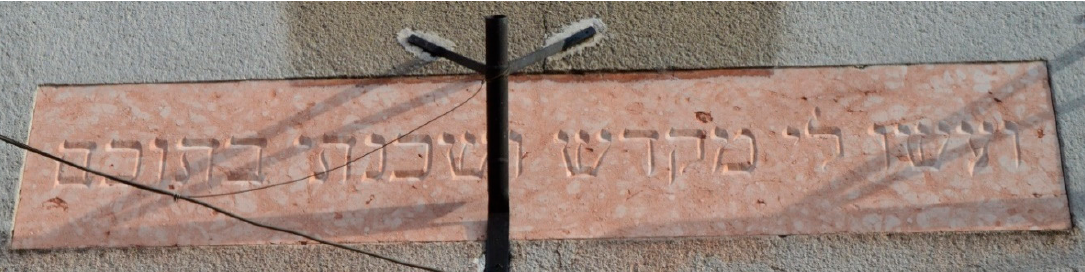
Figure 10. Inscription above the main entrance to the Zemun synagogue.